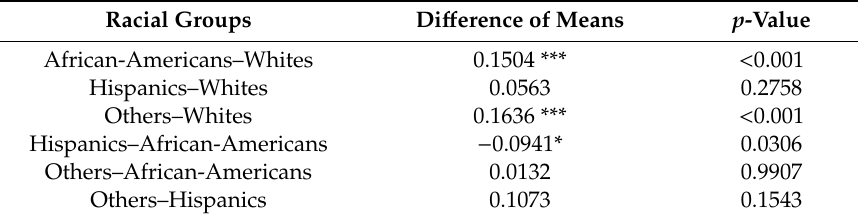
Table 1. Racial di ff erences in exposure to tra ffi c-related PM 2.5 .